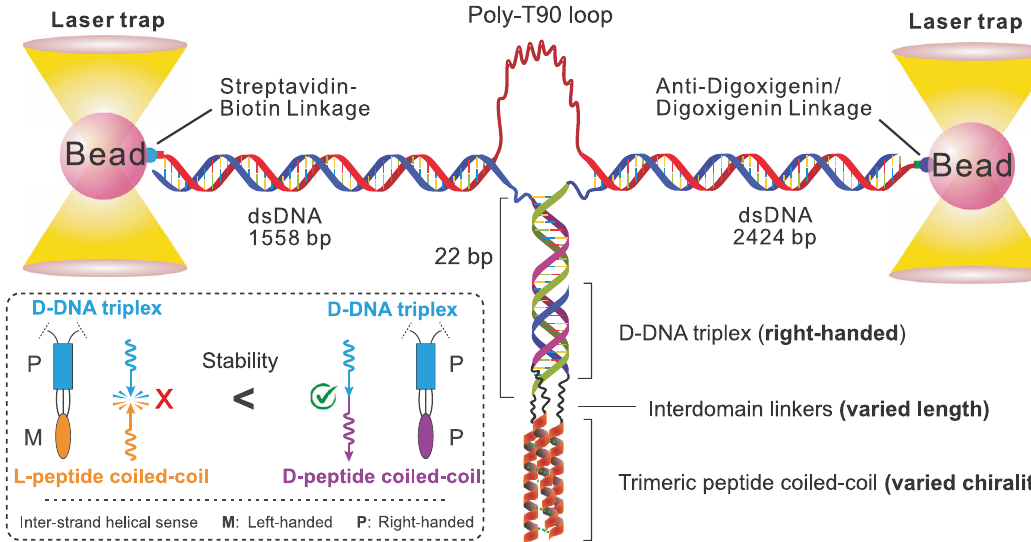
Fig. 1 Schematic of optical-tweezers set up for high-throughput single-molecule assay. The inter-strand helical sense match/mismatch effects between the two macromolecular domains are shown in the bottom left inset in which the D-DNA triplex is marked in cyan rectangle, L-peptide coiled-coil in orange ellipse and D-peptide coiled-coil in purple ellipse. M and P stand for left-handed and right-handed inter-strand helical senses, respectively. The clash symbol depicts the helical sense mismatch state, which has unfavourable energy cost and thus is marked by a red-cross. The no clash symbol represents the helical sense match state, which should not in fl uence the stability and thus is marked by a green